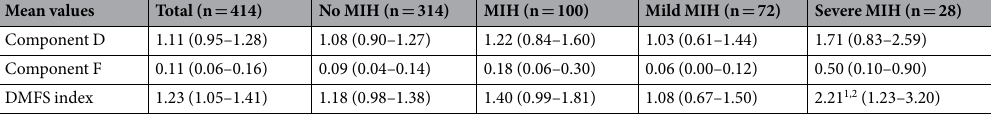
Table 1. DMFS distribution for children with and without MIH. Mean values with 95% CI in parentheses. For both groups, M was a constant equal to zero. 1 Significant difference compared to no MIH according to post-hoc ANOVA (p < 0.05). 2 Significant difference compared to mild MIH according to post-hoc ANOVA (p <